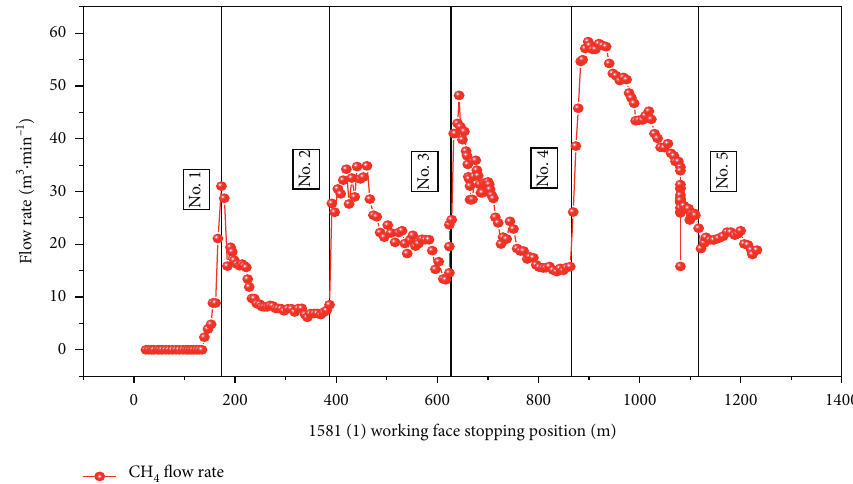
Figure 4: Cooperative extraction of five surface wells in 1581(1) working